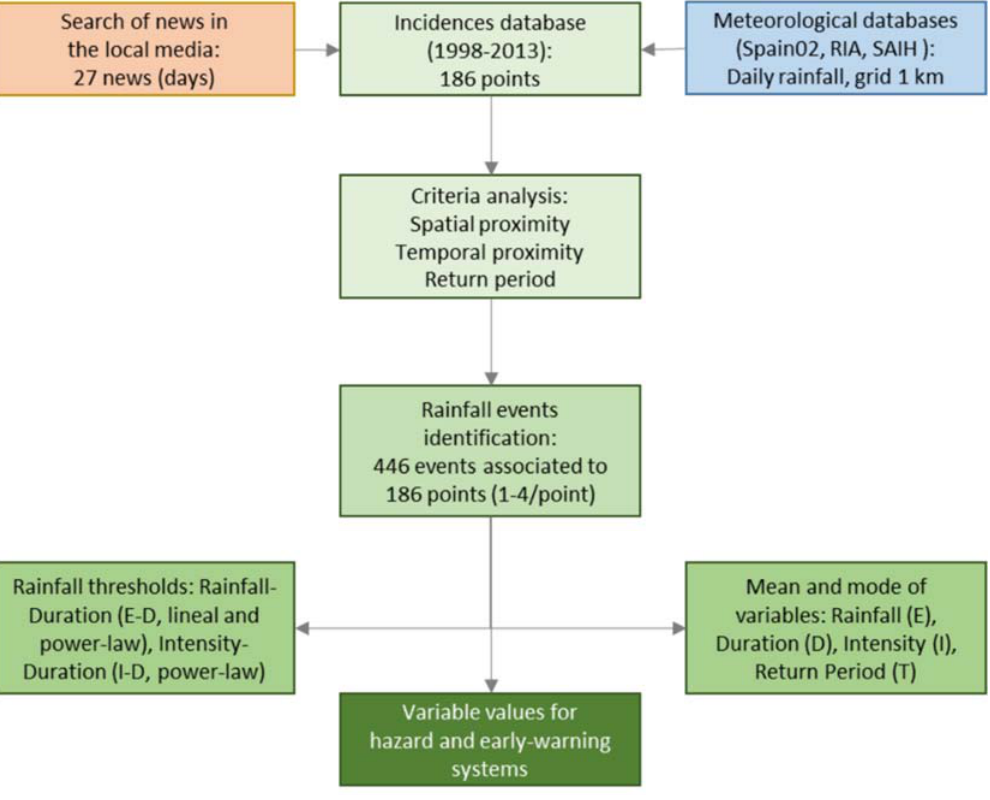
Figure 2. Methodology workflow.